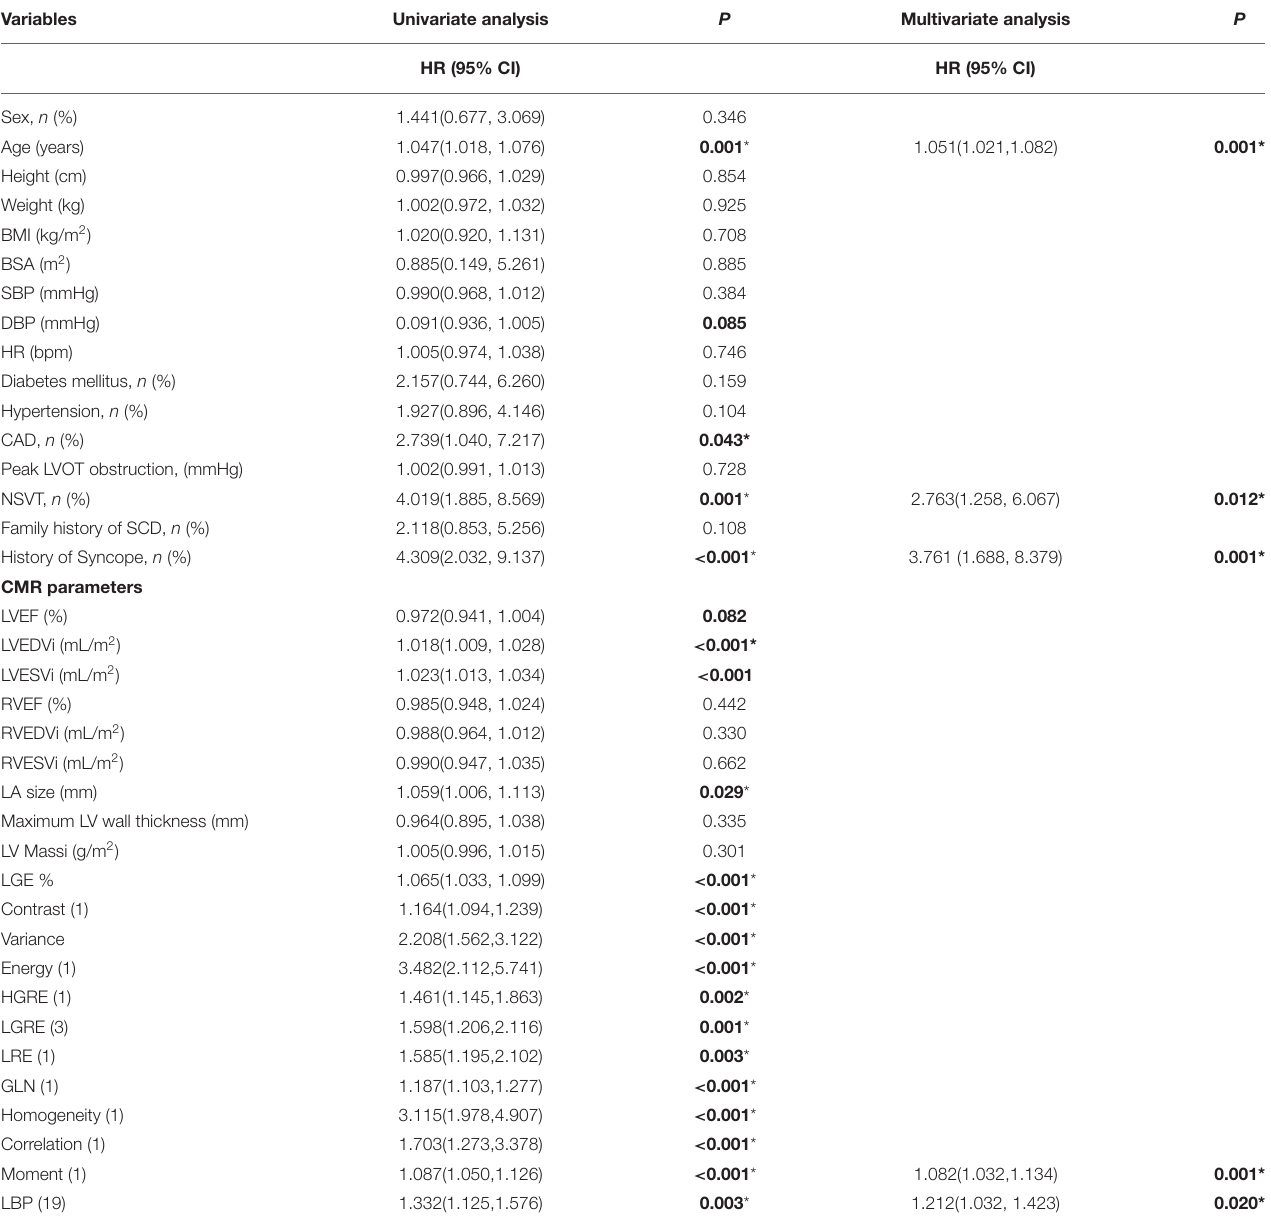
TABLE 2 | Univariable and multivariable Cox regression analysis of clinical variables and selected radiomics features for predicting the sudden cardiac death endpoint in participants with HCM. Variables